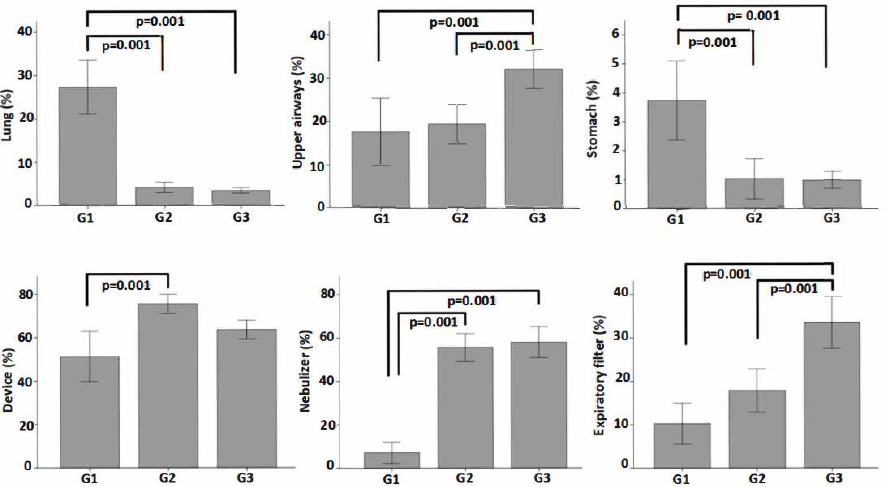
Figure 5. Graphical analysis of the difference between each device configuration with a mean (±SD) % deposition in the lungs, upper airways and stomach, device (including nebulizer, VHC or T-piece), nebulizer alone, and expiratory filter. G1: mesh nebulizer with VHC, G2: jet nebulizer with VHC, G3: jet nebulizer alone. Table 2. Median and interquartile range (IQR) of aerosol deposition measured in the lungs, upper airways, stomach, the device (including nebulizer, VHC or T-piece), nebulizer alone, and expiratory filter. (G1: mesh nebulizer with VHC, G2: Jet nebulizer with VHC, G3: Jet nebulizer alone).